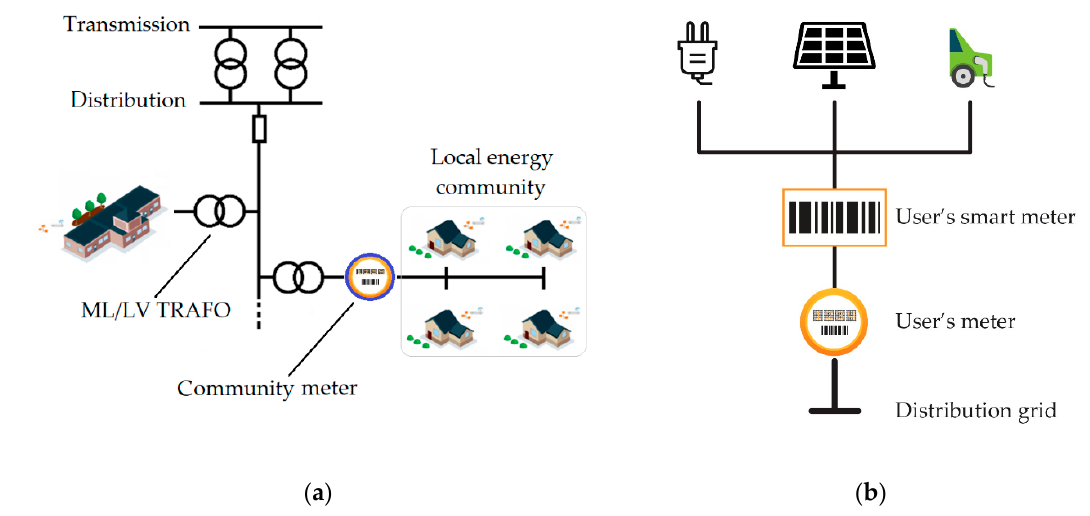
Figure 2. ( a ) The energy community and ( b ) the community members’ equipment.